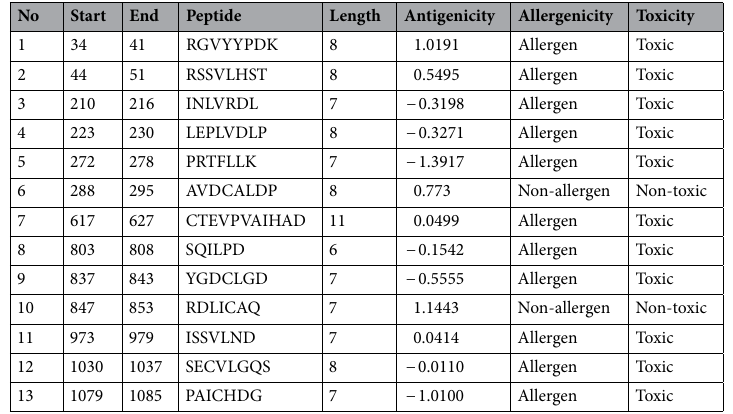
Table 2. List of known amino acid antigenicity predicted using Kolaskar and Tongaonkar method 33 .